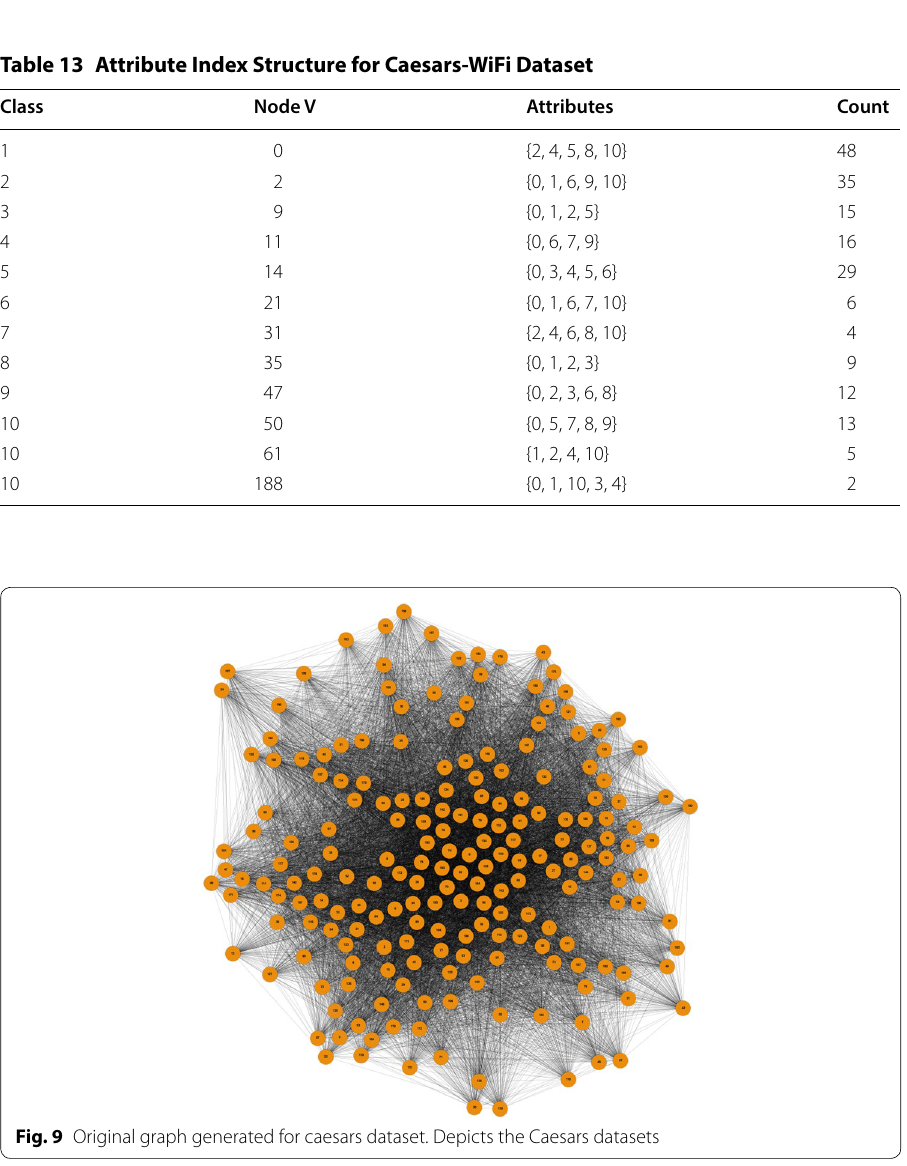
Fig. 9 Original graph generated for caesars dataset. Depicts the Caesars